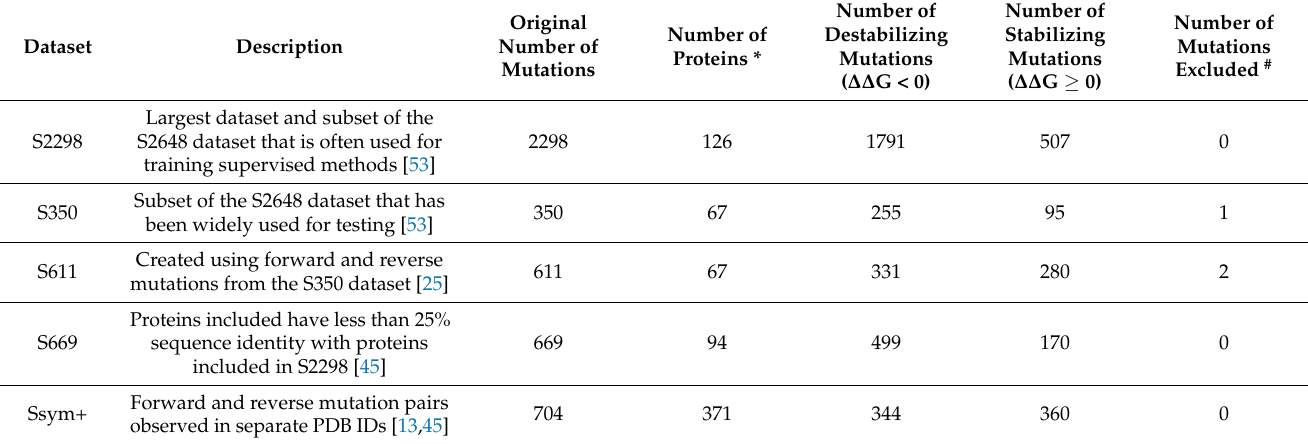
Table 10. Datasets used in this study. The S2298 dataset was used to optimize the parameters